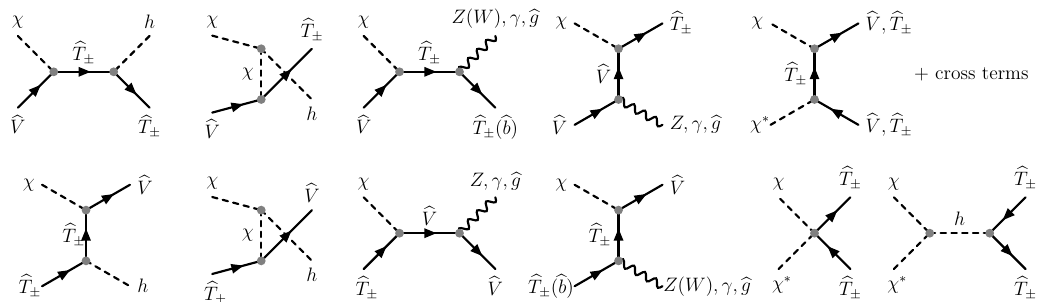
Figure 10 . The Feynman diagrams for the DM semi-annihilation/conversion through the dark